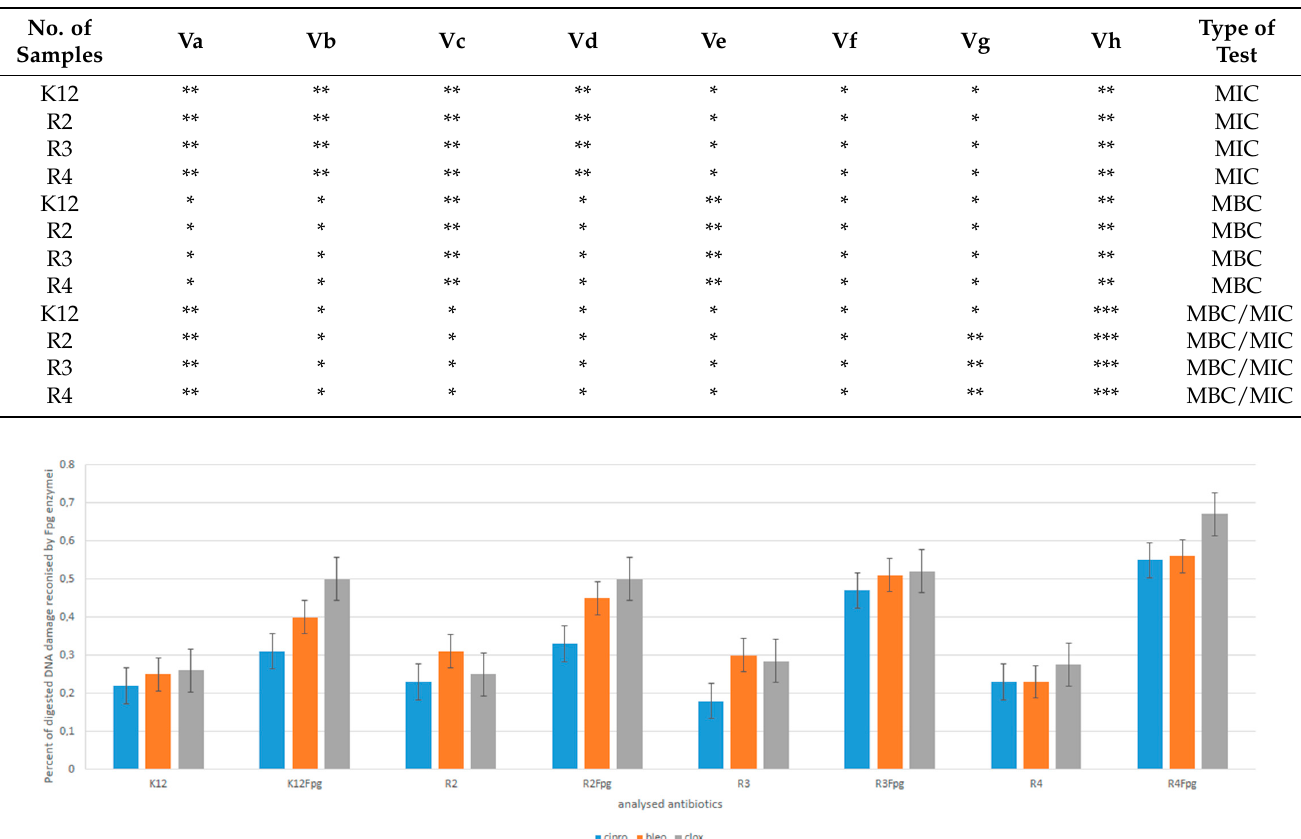
Figure 7. Examples of MIC with model bacterial strains K12, R2, R3, and R4 for studying antibiotics ciprofloxacin (cipro), bleomycin (bleo), and cloxacillin (clox). The x -axis features antibiotics used sequentially. The y -axis features the MIC value in μ g/mL − 1 . Supplementary Materials Figure S1. Table 3. Statistical analysis of all analyzed compounds by MIC, MBC, and MBC/MIC; <0.05 *, <0.01 **, <0.001 ***.